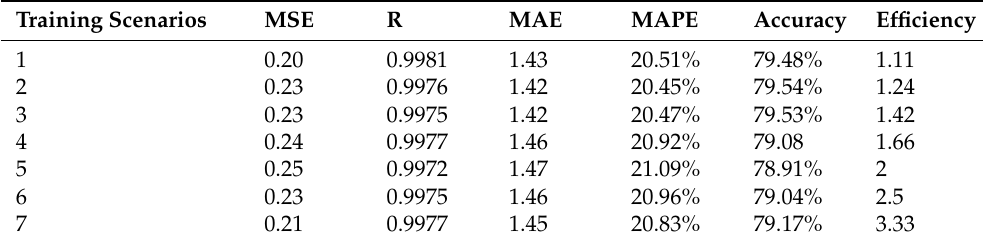
Table 4. DLSA testing data